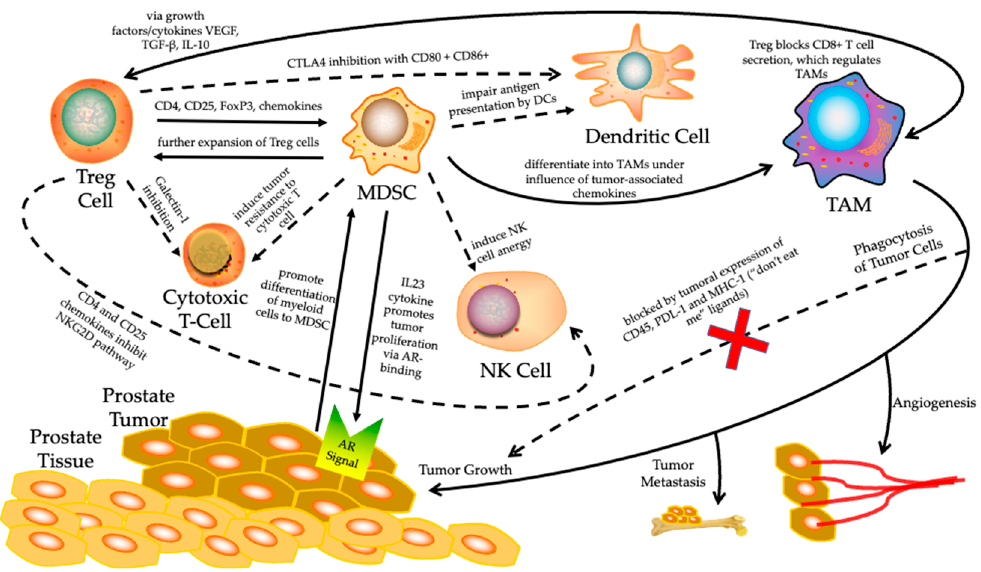
Figure 1. The tumor immune microenvironment (TIME) surrounding prostate cancer. It is known to be highly immunosuppressive, utilizing many cellular pathways which inhibit normal immune function and promote a tumor’s unchecked proliferation. Solid arrows represent upregulation of that cell’s expression or a specific function at the end of the arrow. Dashed arrows indicate inhibition of the cell or function at the end of the arrow. Specific mechanisms by which upregulation or inhibition work are summarized on their respective arrows. Treg, regulatory T; MDSC, myeloid-derived suppressor cell; NK, natural killer; TAM, tumor-associated macrophage; DC, dendritic cell; AR, androgen receptor.